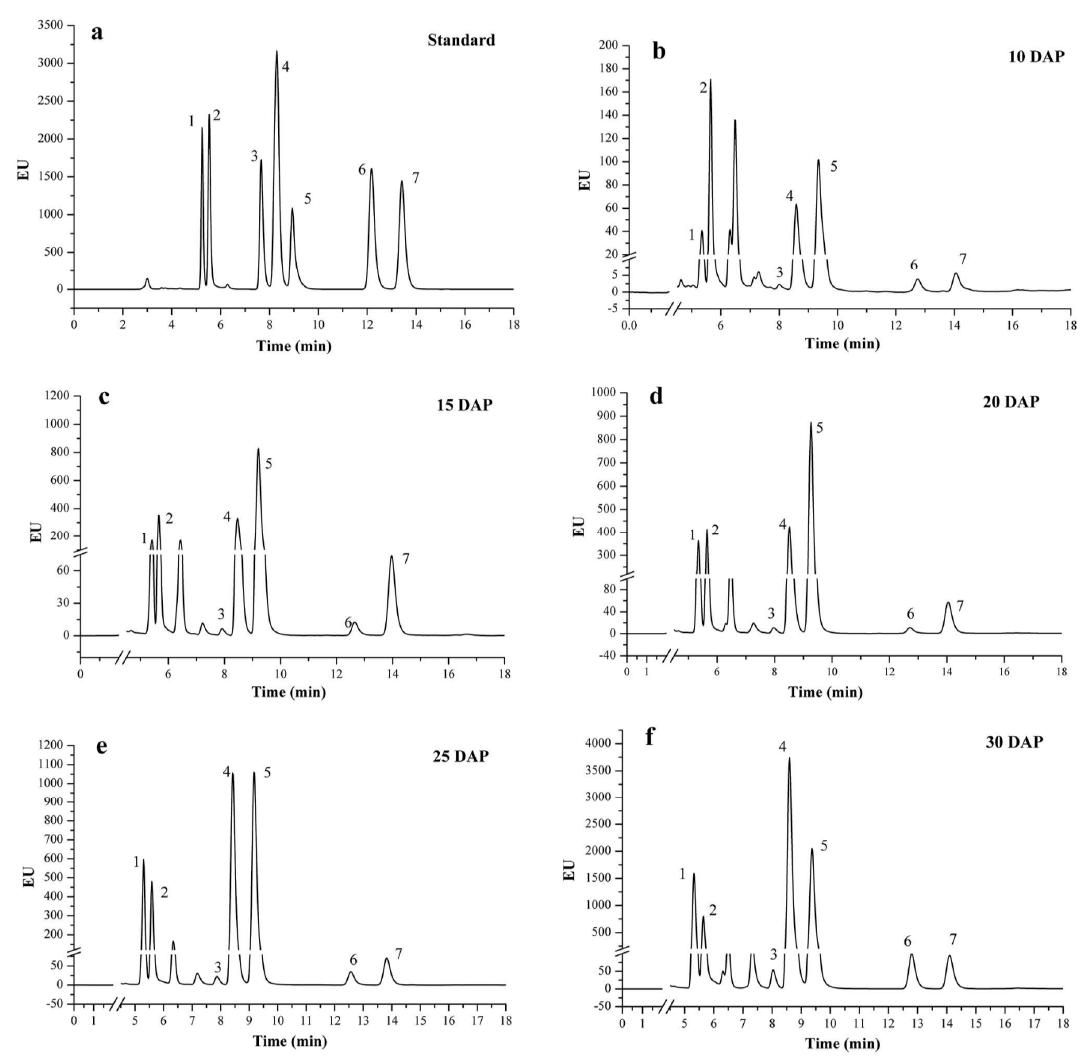
Figure 2. NP-HPLC chromatogram of vitamin E standard and extracts in sweet corn during kernel development (numbers 1–7 represent α -T, α -T3, β -T, γ -T, γ -T3, δ -T, δ -T3, respectively, T means tocopherol, and T3 means tocotrienol). ( a ) is the chromatograms of vitamin E standards; ( b – f ) are the chromatograms of sweet corn extracts from 10 DAP to 30 DAP. EU = Emission Unit.